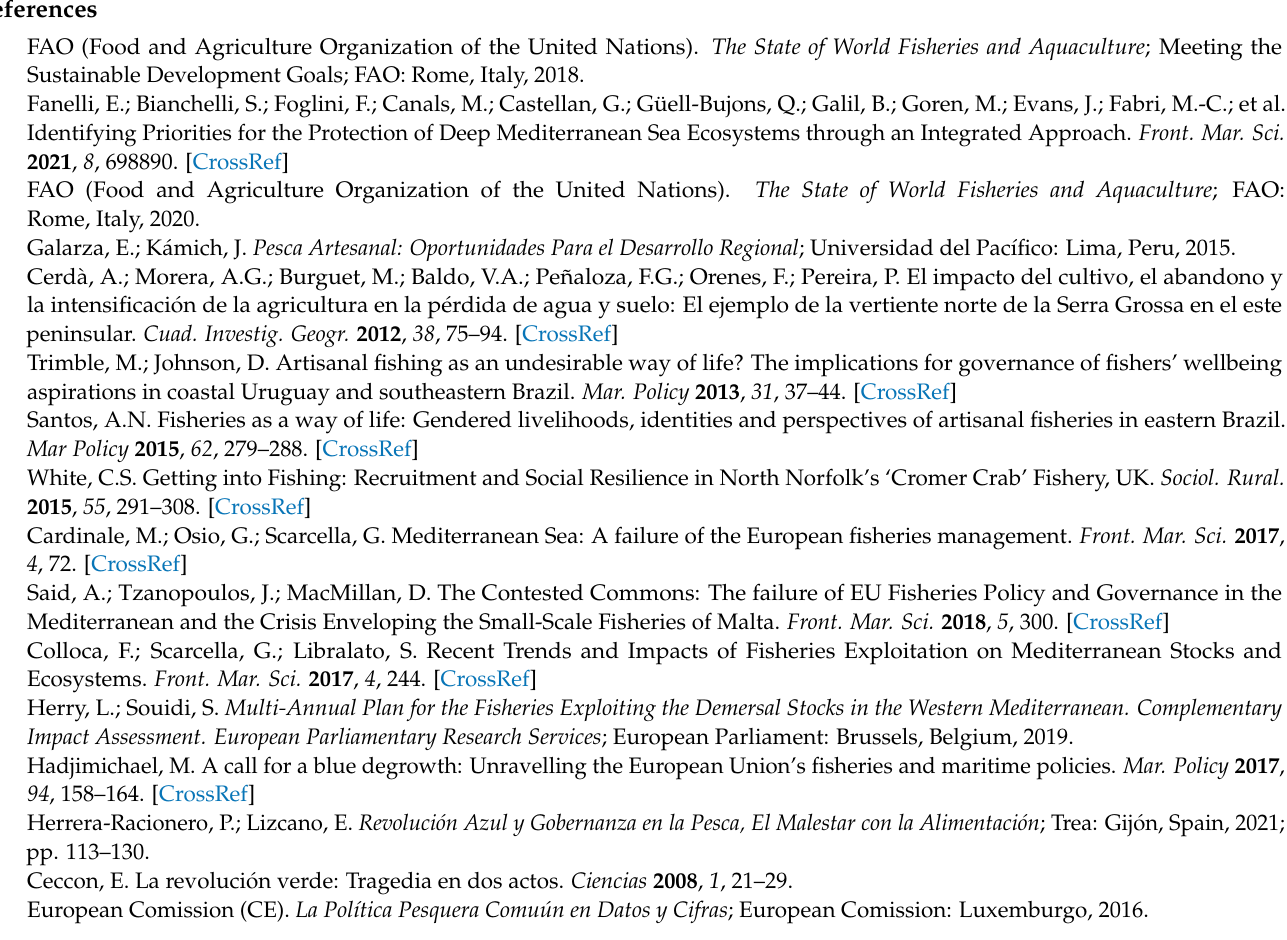
General expression of a straight line: y = b0 + b1x, where b0 and b1 are coefficients and the ‘x’ corresponds to the explanatory or independent variable, which in this case is time. Source: Own elaboration. The original data for both variables are shown in blue and the values predicted from the linear regression models in